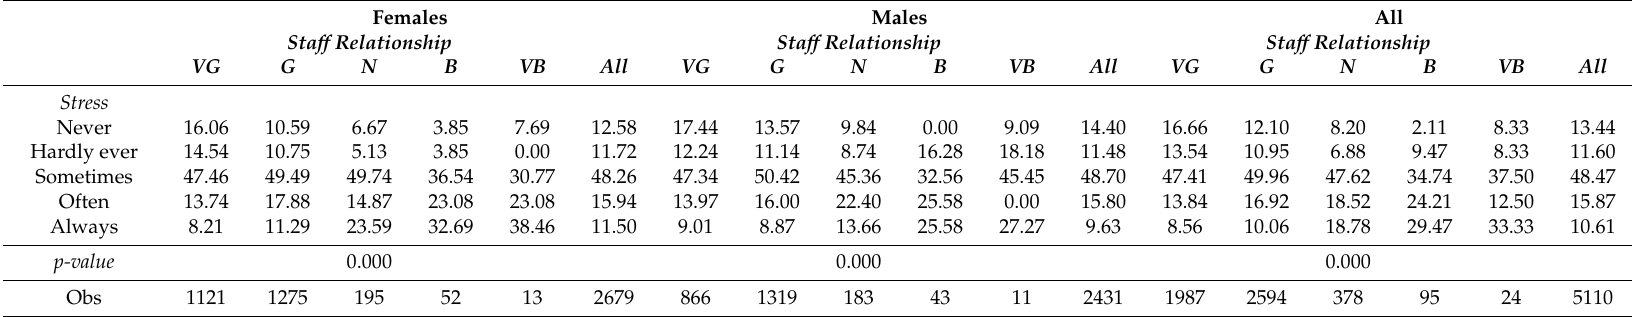
Table A3. Cross tabulations of stress and staff relationship by gender and overall